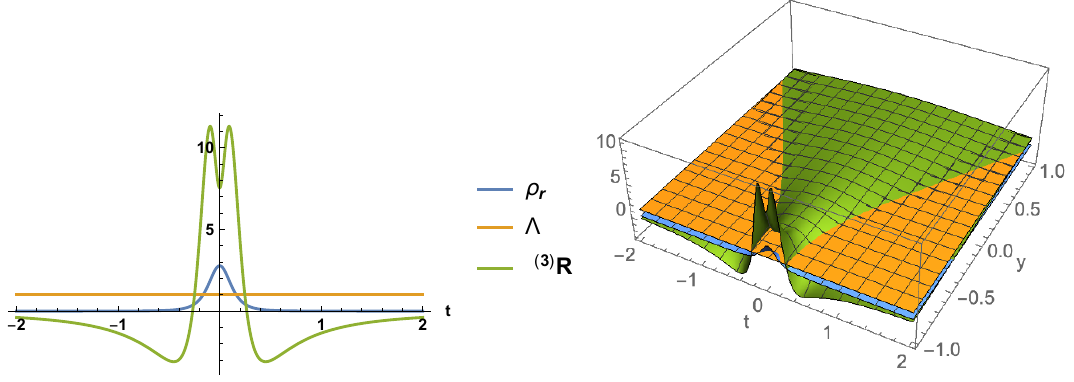
Figure 5 . An example where the spatial curvature changes sign in some regions, just before and after the bounce, which occurs at t = 0. In blue is shown the energy density of the electromagnetic field, in orange that of the cosmological constant (equal to Λ = 1), while the green curve/surface shows the 3-curvature. The parameter values are σ = 4 , α = 4 / 5 , q 1 = 1 / 20 , q 2 = 0 . Left panel: 1 . Right panel: 1 y = y − − ≤ ≤